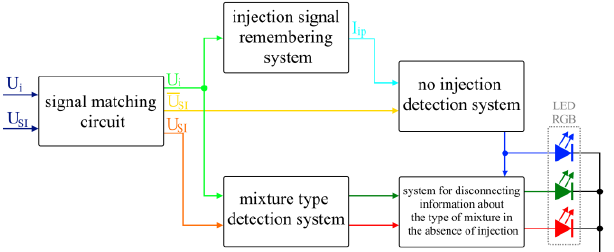
Fig. 6. Block diagram of the indicator of the type of a combustion mixture used to supply an SI engine with direct fuel injection